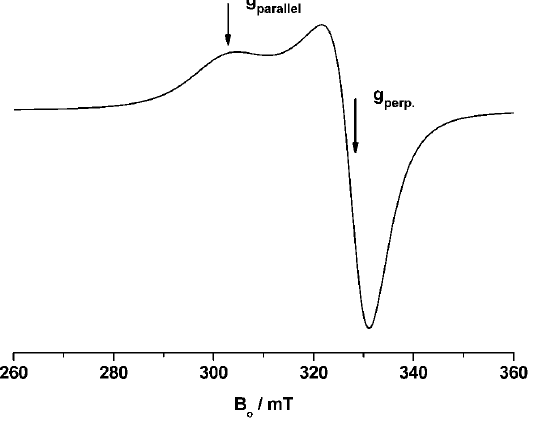
Figure 3. Electron paramagnetic resonance (EPR) spectrum of (EtPh 3 P) 2 [CuBr 4 ] ( 7 ) at 150 K. Table 6. Experimental g -values ( g ‖ , g ⊥ and g iso ), calculated values g av and known cis -angles ( φ av ) for this series of tetrabromidocuprates(II).